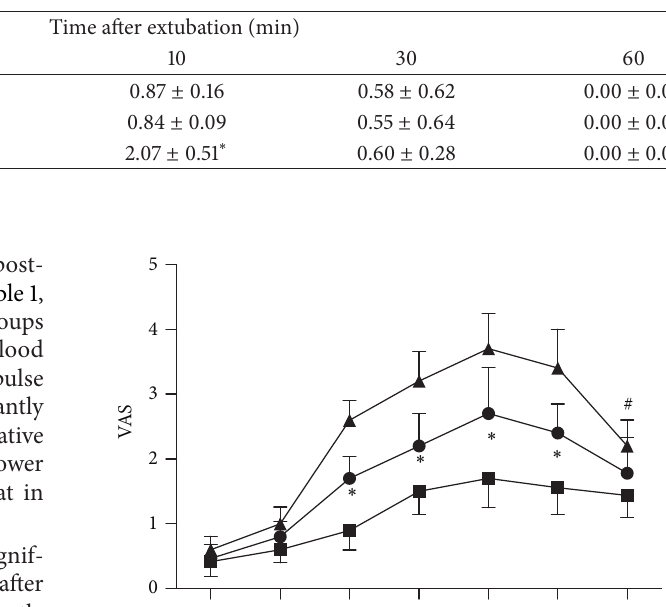
Table 2: Emergence agitation score among the three groups (mean ± SD).